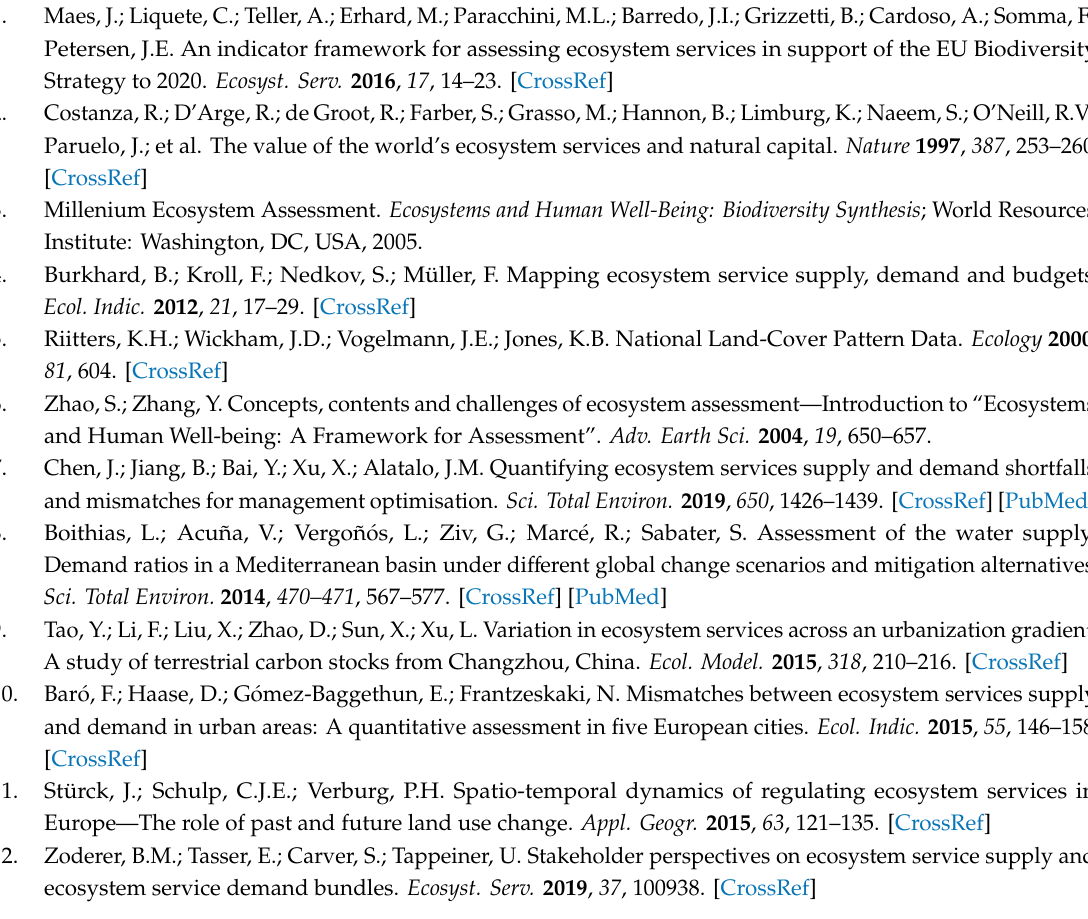
Table S1: Data used to quantify ecosystem services (ES) supply and demand in Wuhan; Table S2: Key parameters used to quantify ecosystem services (ES) supply and demand in